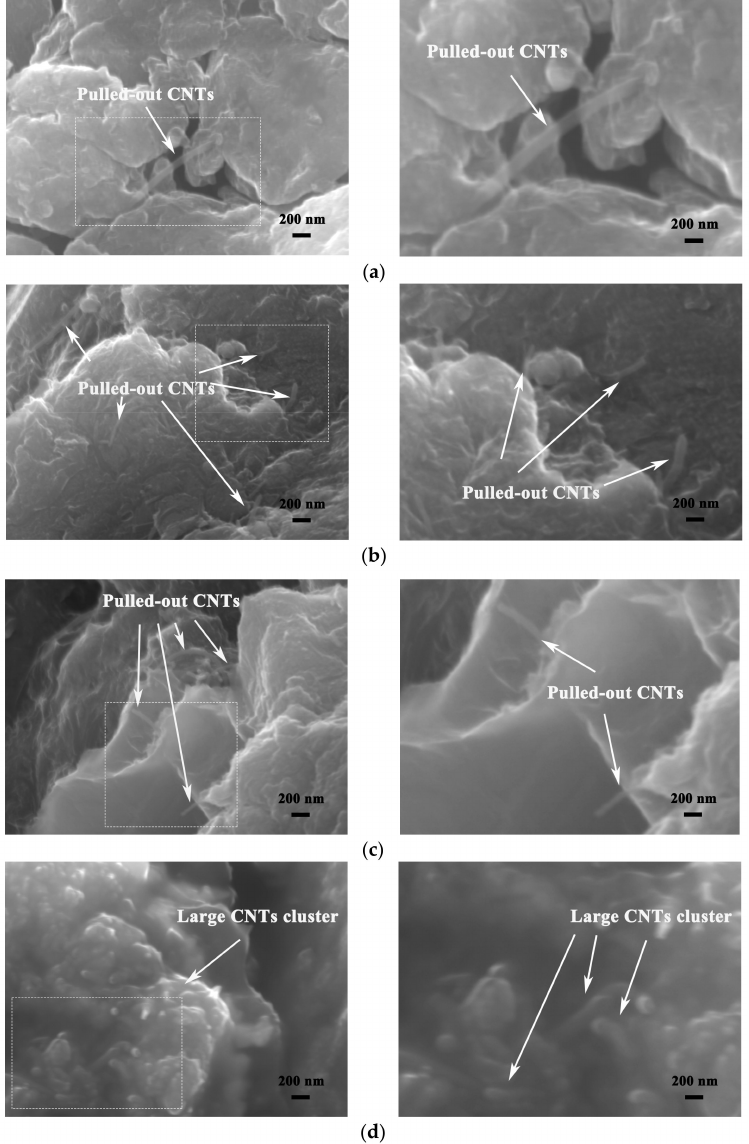
Figure 8. SEM images of fracture morphology in CNTs/refined-AZ61 composite with different